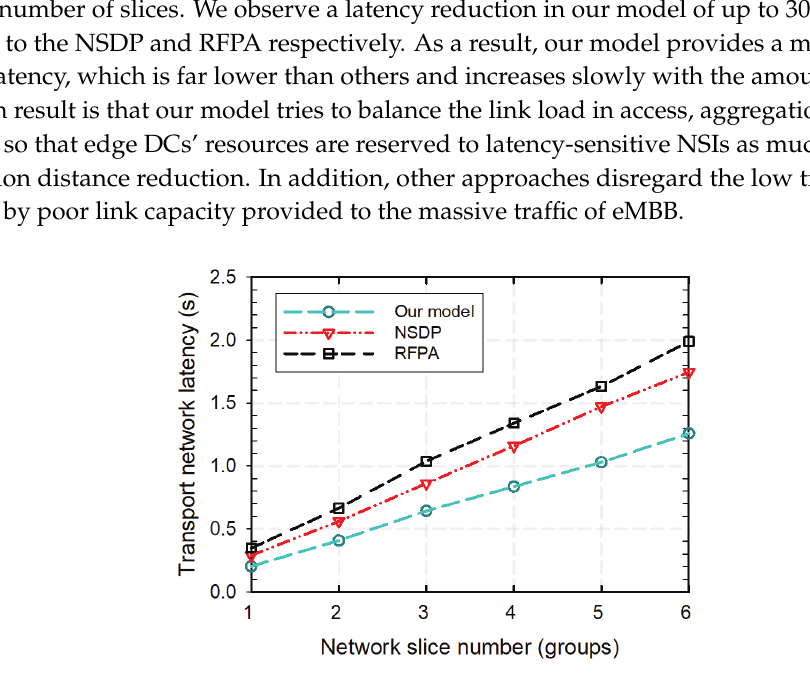
Figure 6. Transport network latency comparison among proposed model, NSDP and